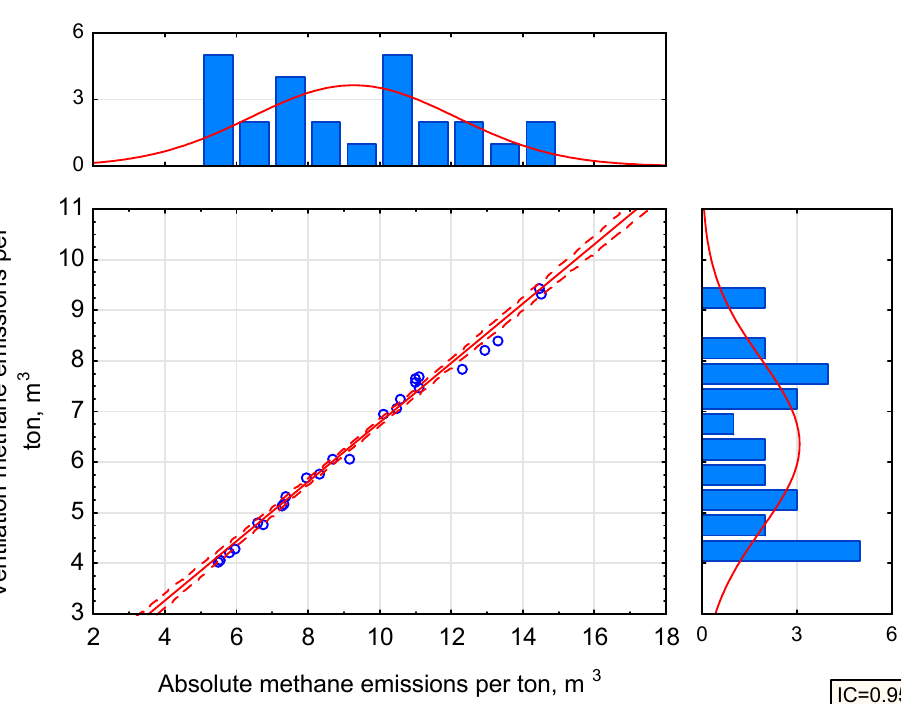
Figure 9. Relationship between absolute methane emissions and ventilation methane emissions per one ton in hard coal mines in Poland.